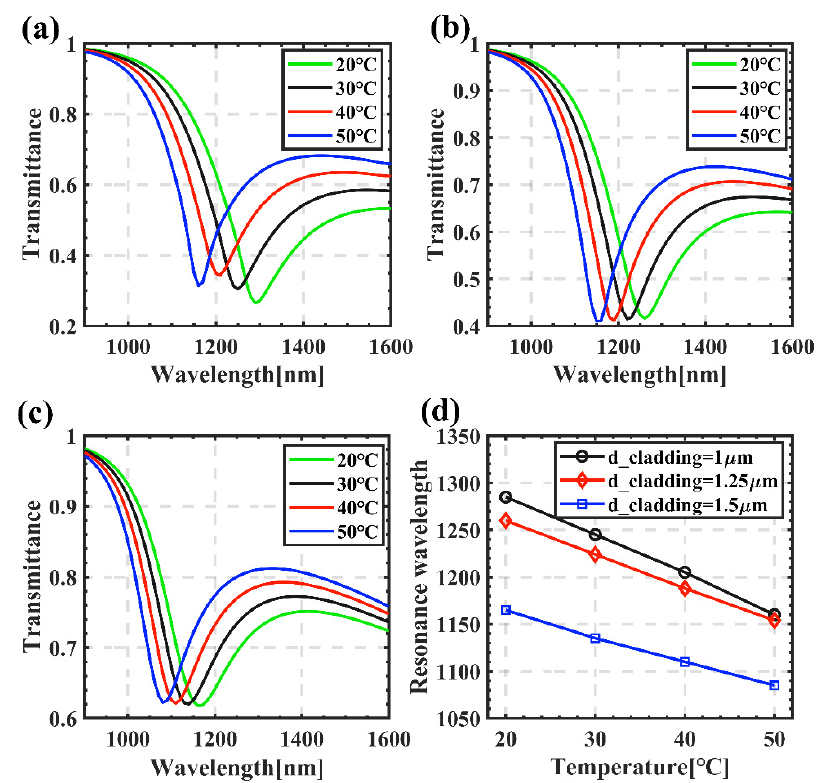
Figure 3. Influence of d_cladding on the transmittance spectra: ( a ) d_cladding = 1 µ m; ( b ) d_cladding =